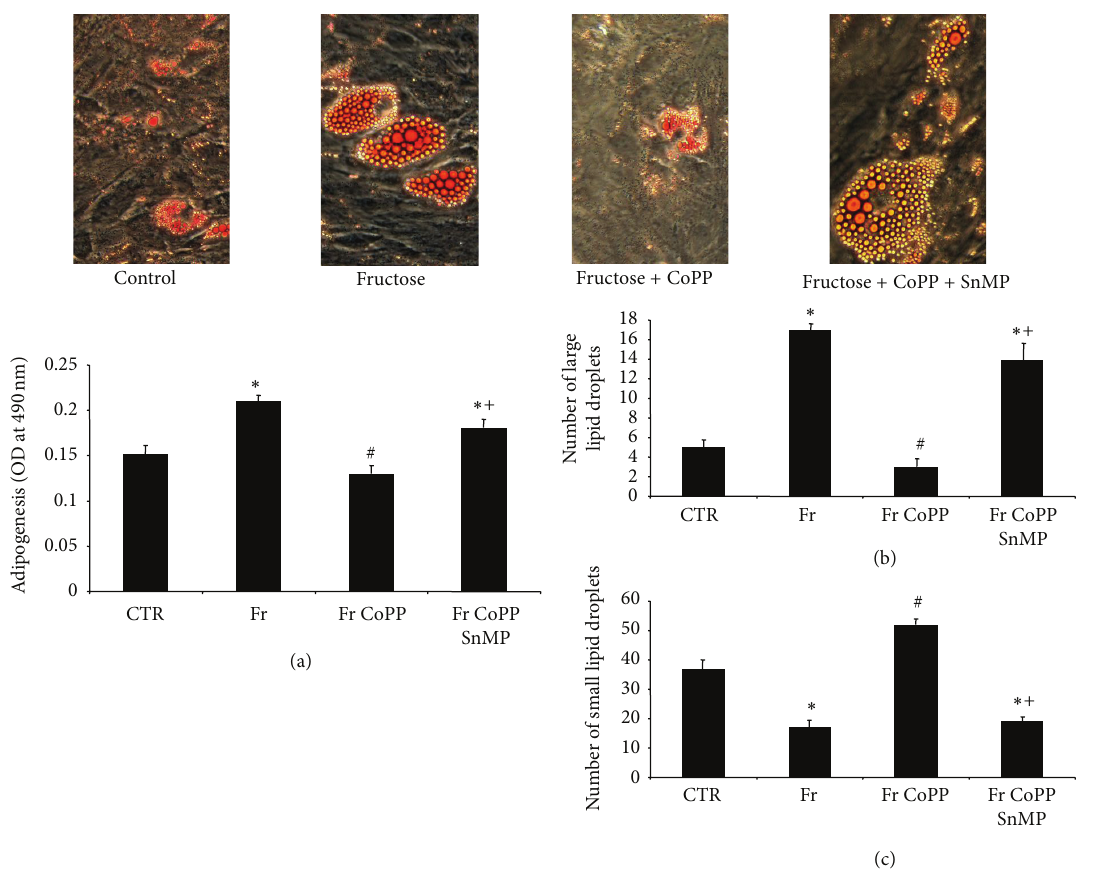
Figure 3: (a) Adipogenesis as shown by Oil Red O staining in MSCs treated with 500 𝜇 M fructose with or without CoPP, in the presence or absence of SnMP, magnifications and lipid droplet size from Oil Red O stained MSCs: 40x ( 𝑛 = 3 ). A representative section for each group is shown. (b) Number of large lipid droplets from Oil Red O stained MSCs treated with 500 𝜇 M fructose with or without CoPP, in the presence or absence of SnMP. (c) Number of small lipid droplets from Oil Red O treated with 500 𝜇 M fructose with or without CoPP, in the presence or absence of SnMP. Values represent means ± SEM of five independent treatments. ∗ 𝑃 < 0.05 versus control or # 𝑃 < 0.05 versus fructose or + 𝑃 < 0.05 versus fructose +